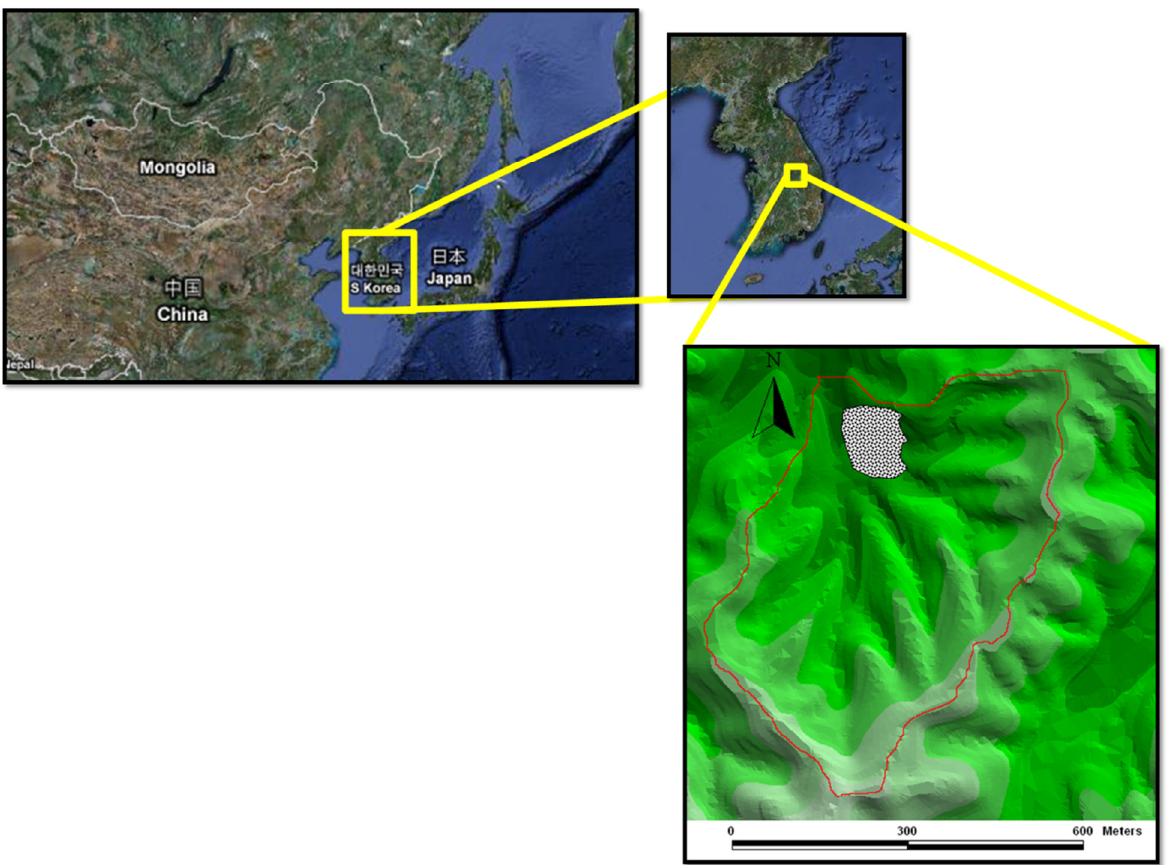
Figure 8. Location of Study Watershed–Jaun-ri Watershed, Gangwon,